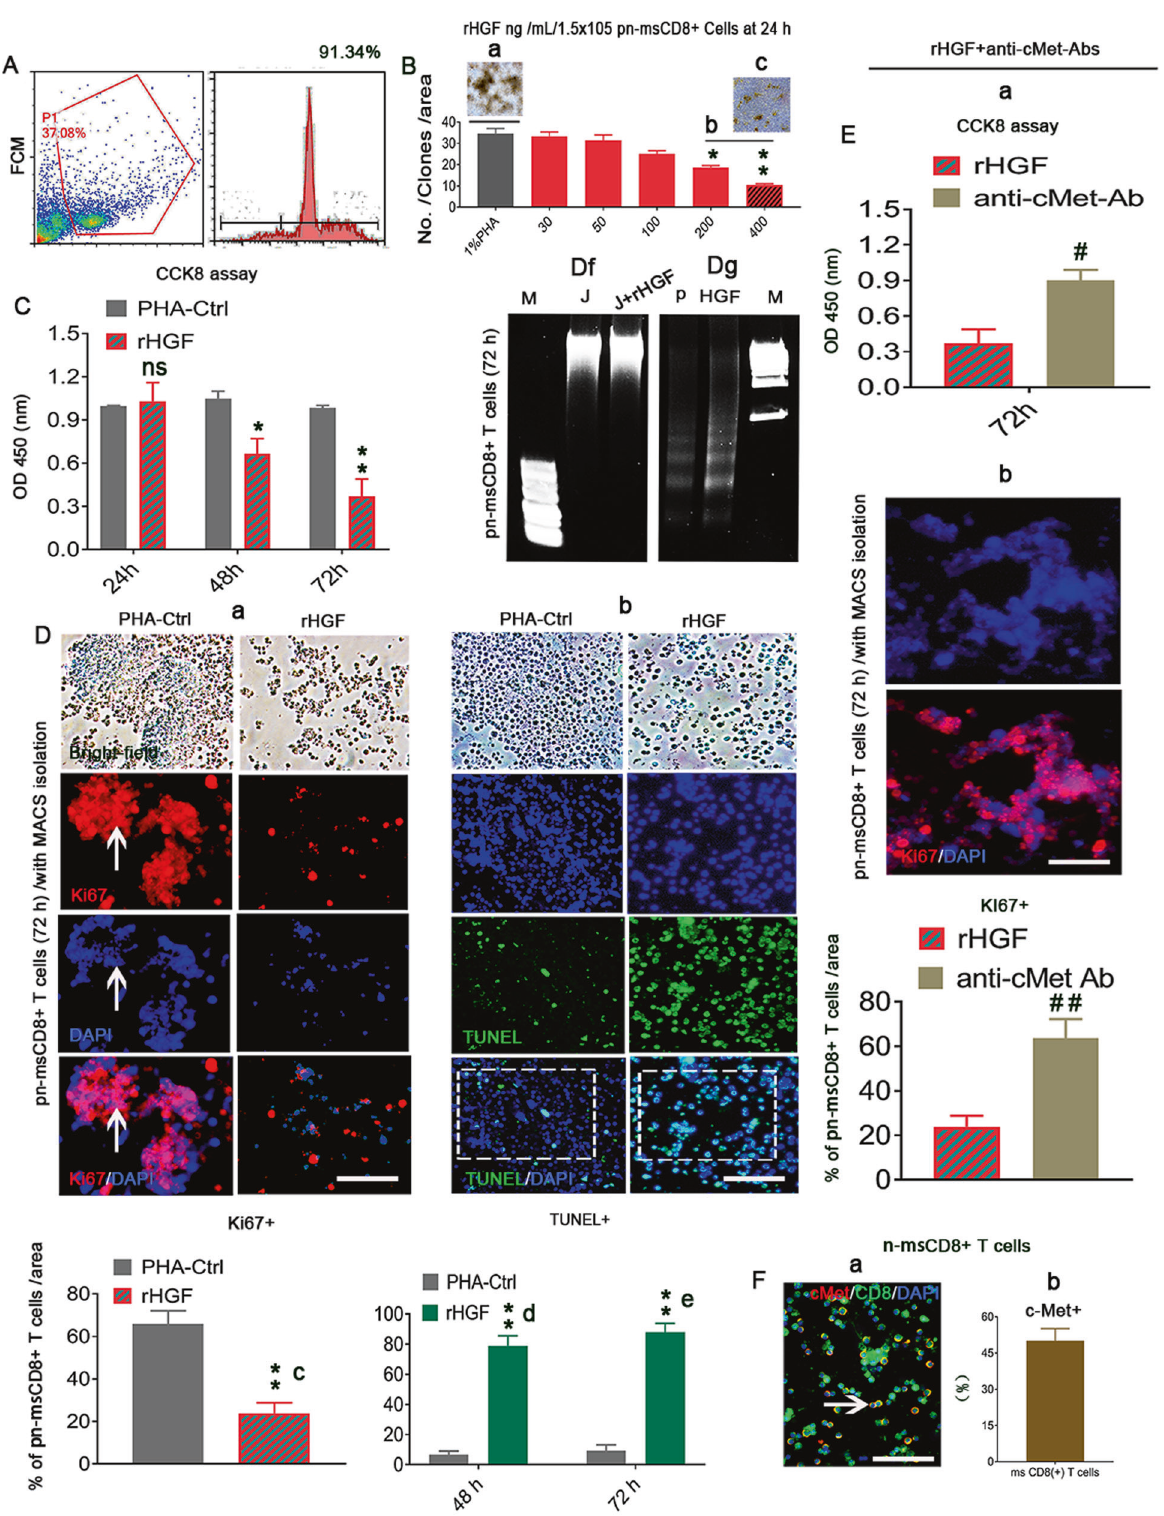
to 200 ng/mL rHGF induced a signi fi cant (* p < 0.05) decrease in the number of clones (Fig. 2Bb) compared with those obtained with PHA-stimulated n-msCD8 + T cell controls (1%PHA, Fig. 2Ba), and an even more signi fi cant (** p < 0.01) reduction was observed with 400 ng/mL rHGF (Fig. 2Bc). Thus, 400 ng/mL rHGF